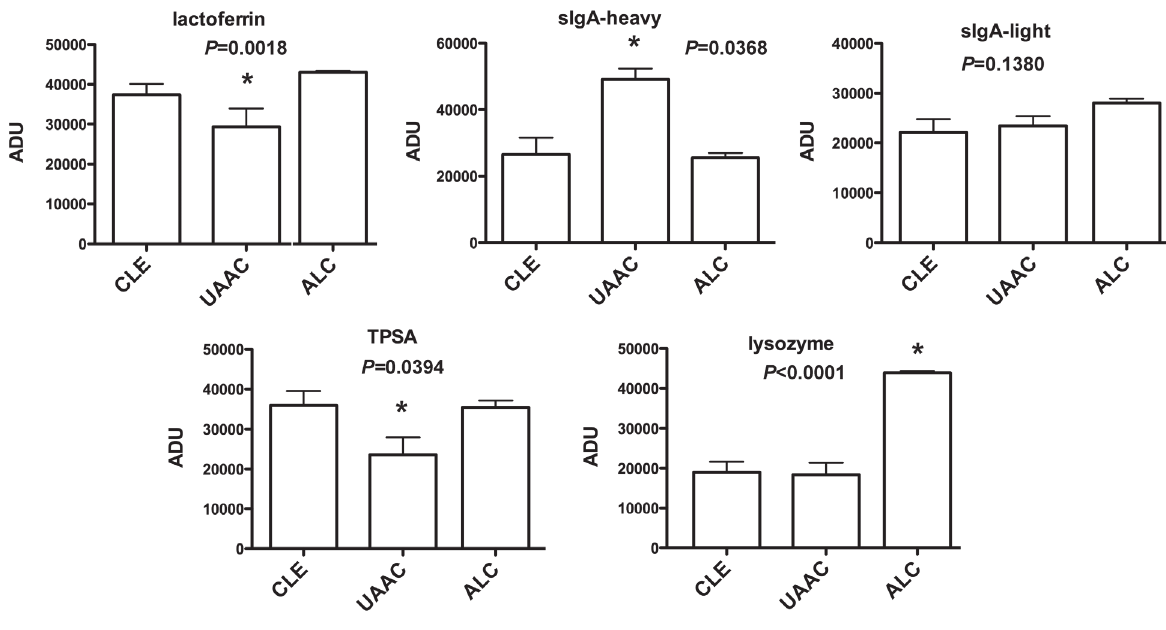
Figure 3 - Protein quantification in tear of allergic and adenoviral conjunctivitis. Protein bands of human tear fluid on SDS-PAGE were quantified by densitometry: lactoferrin (79 kDa), serum albumin and sIgA-heavy chain (66 kDa), sIgA-light chain (27 kDa), lipocalin (TPSA, 18 kDa), and lysozyme (14 kDa). The results are expressed by arbitrary densitometric units (ADU). Statistical analyses were performed by one way ANOVA and Bonferroni's post test. Abbreviations: CLE, contralateral non-affected eye; UAAC, unilateral acute adenoviral conjunctivitis eye; ALC, allergic